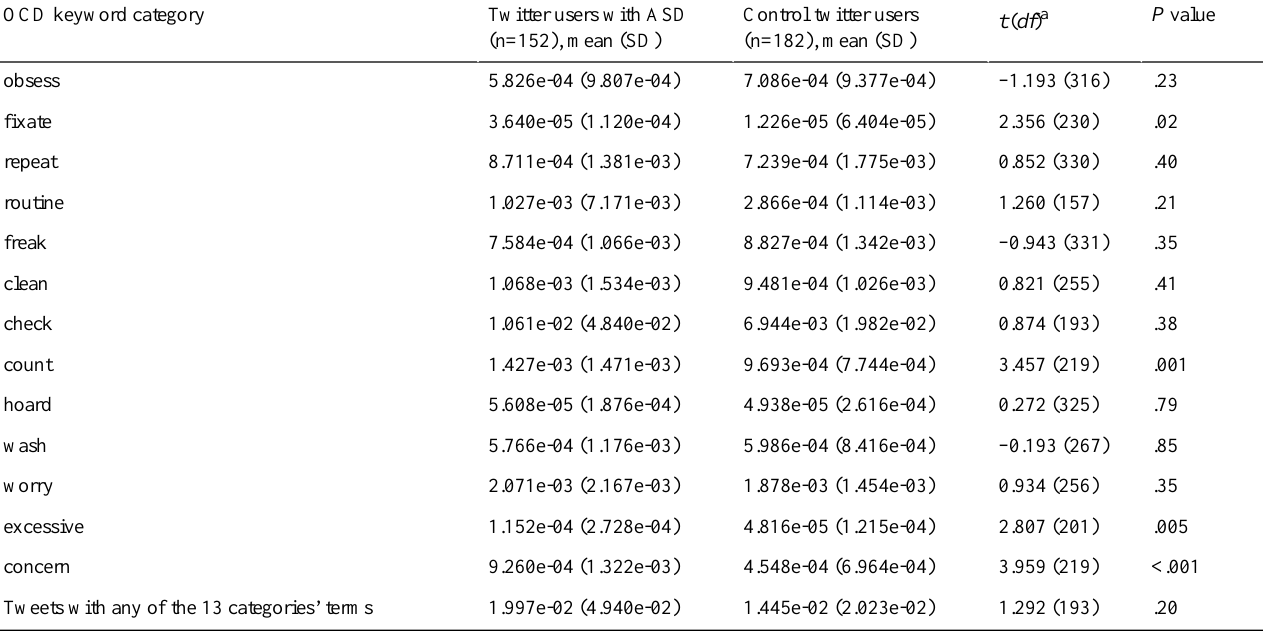
Table 5. Tweets containing obsessive-compulsive disorder (OCD)–related keywords among Twitter users with autism spectrum disorder (ASD) and control